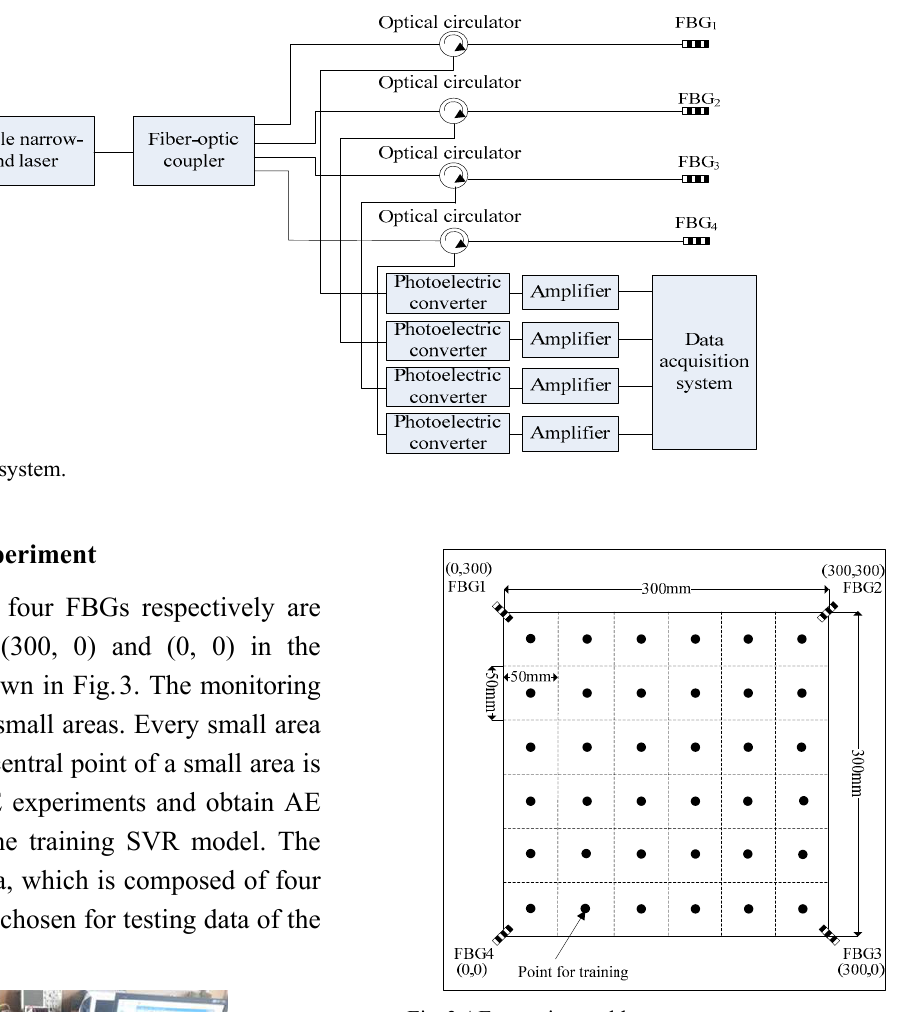
Fig. 3 AE experimental